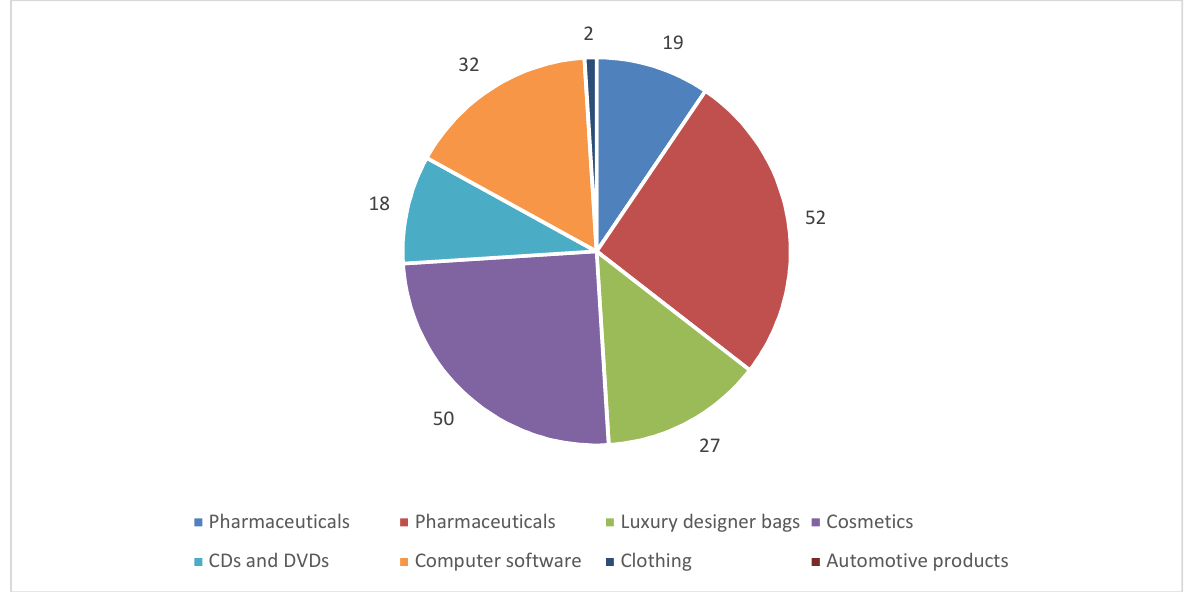
Fig. 2. Counterfeit Products Purchased by the